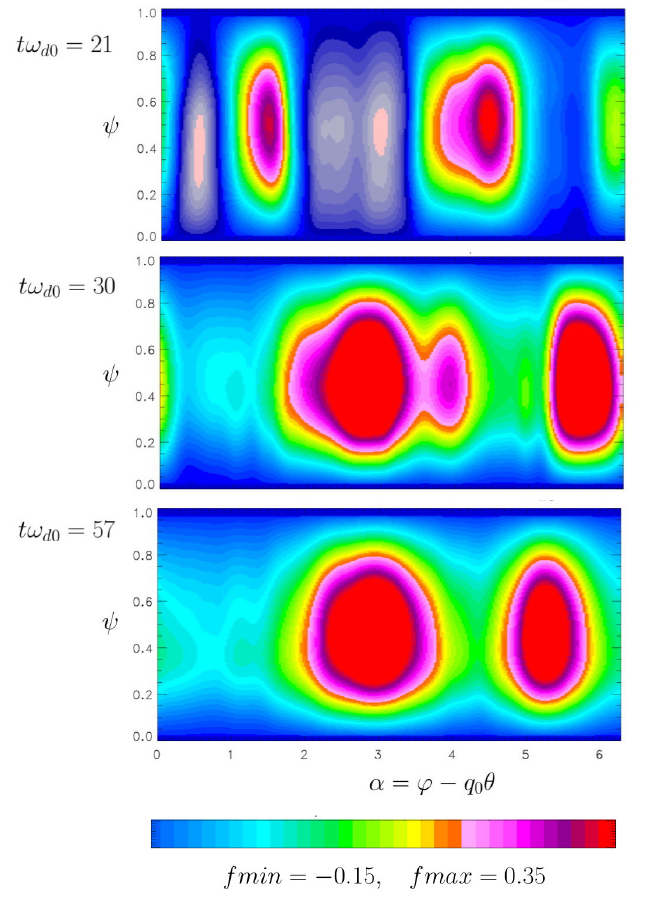
Figure 6. Continuing the results of simulation shown in Figures 4 and 5, the electric potential is plotted at three different times when the resonance takes place, showing clearly that the dominant modes are n = 1 and n = 2 in the asymptotic regime. We have identified a nonlinear coupling of zonal flow (ZF) mediated by nonlinear collisionless trapped ion modes (TIMs), leading to a strong reduction of the interchange